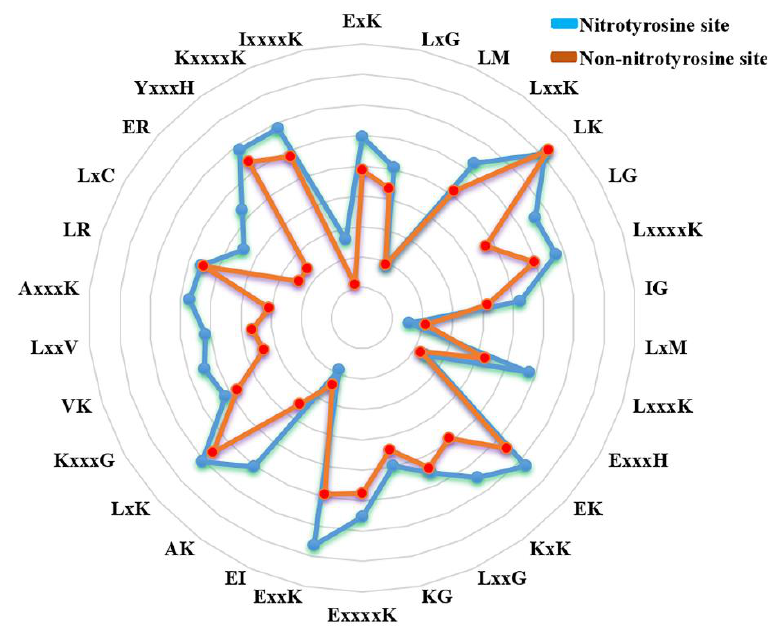
Figure 4. Top 30 amino acid residue pairs selected by the Wilcoxon rank-sum (WR)-based feature selection from the pbCKSAAP scheme. Blue color denotes nitrotyrosine sites and dark red color denotes non-nitrotyrosine sites. The radar diagram is represented by the composition of each residue pair whose length is proportional to the composition of pbCKSAAP features.